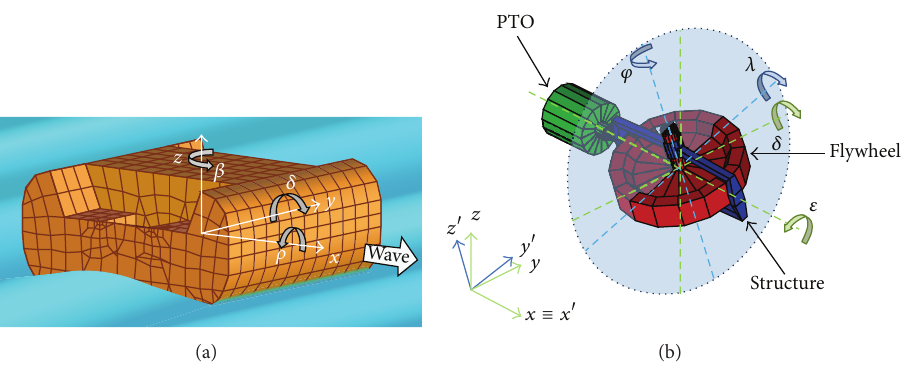
Figure 1: ISWEC geometry and coordinate